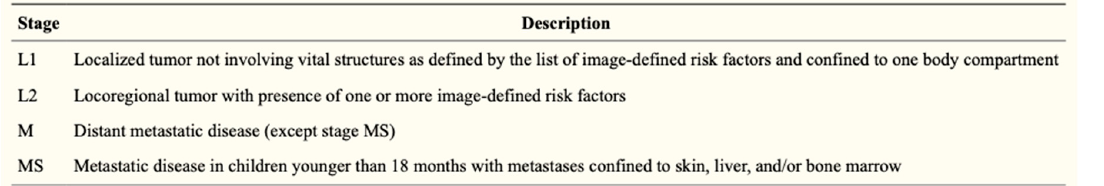
Figure 3. INRG staging system [13] (Reprinted with permission from Monclair T. et al.: J. Clin. Oncol. 27(2): 298–303. © 2009 American Society of Clinical Oncology. All rights reserved.).